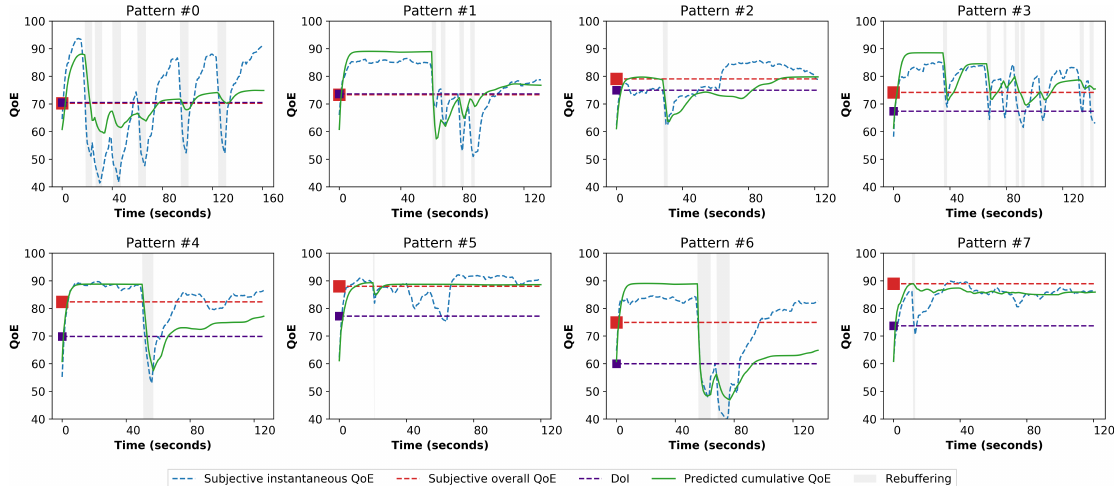
Figure 9. Predicted cumulative QoE in comparison with the subjective overall and instantaneous QoE over eight different playout